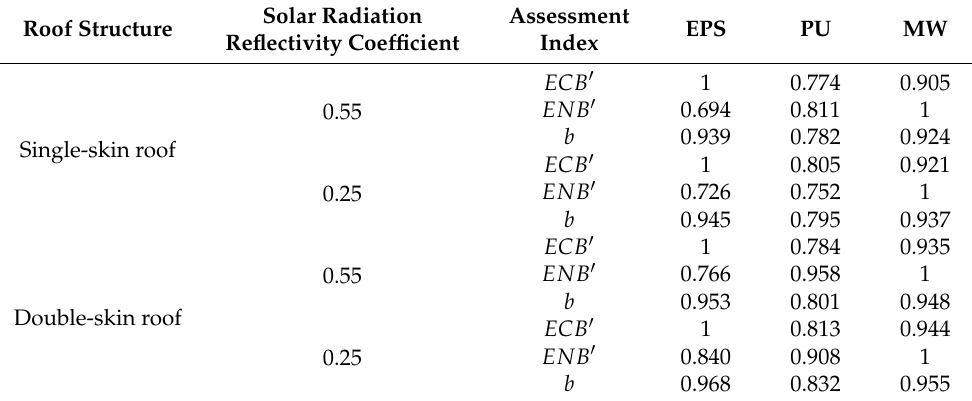
Table 7. Integrated assessment index of thermal insulation. Roof